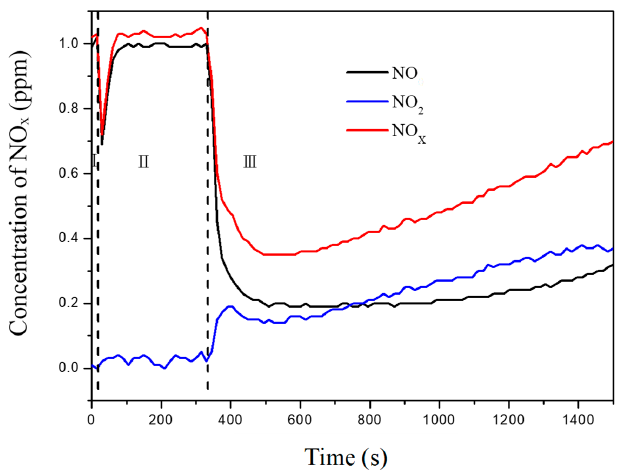
Figure 3. Time course of the changes in concentration of NO, NO 2 , and NO x under UV irradiation in the presence of 100% C–TiO 2 film calcined at 350 °C.